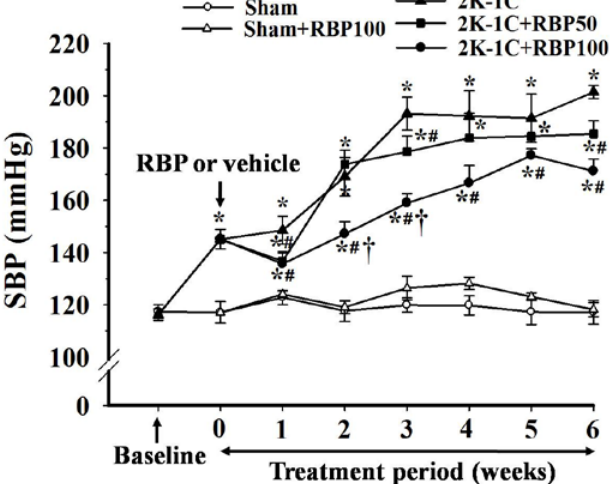
Figure 2. Effect of RBP on systolic blood pressure measured by tail-cuff plethysmography before and after renal artery clipping. Rice bran peptides, RBP; Systolic blood pressure, SBP. Data are mean ± SEM; ( n = 8/group), * p < 0.05 vs. sham-operated group, # p < 0.05 vs. 2K-1C group and † p < 0.05 vs. 2K-1C + RBP50 group.